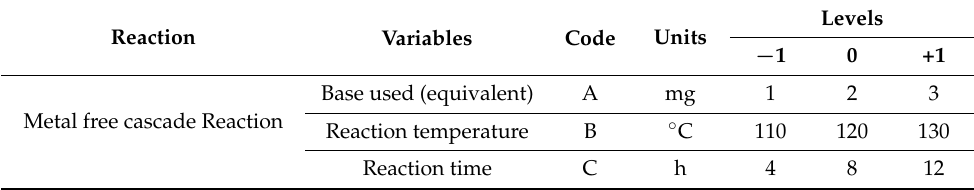
Table 1. A selection of levels and variables used for BBD.